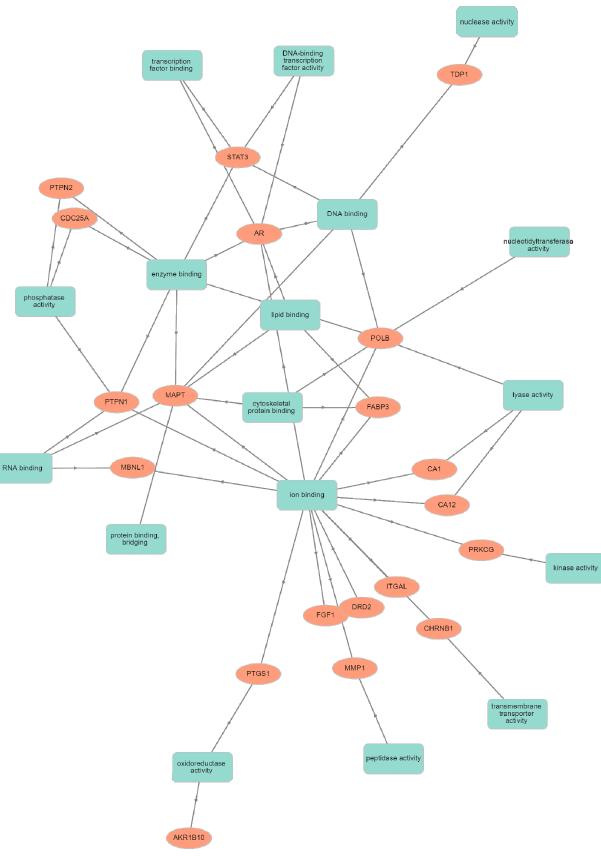
Figure 4. Classification human targets with encoding molecular functions. Orange color encodes human targets; green color represents various molecular functions.